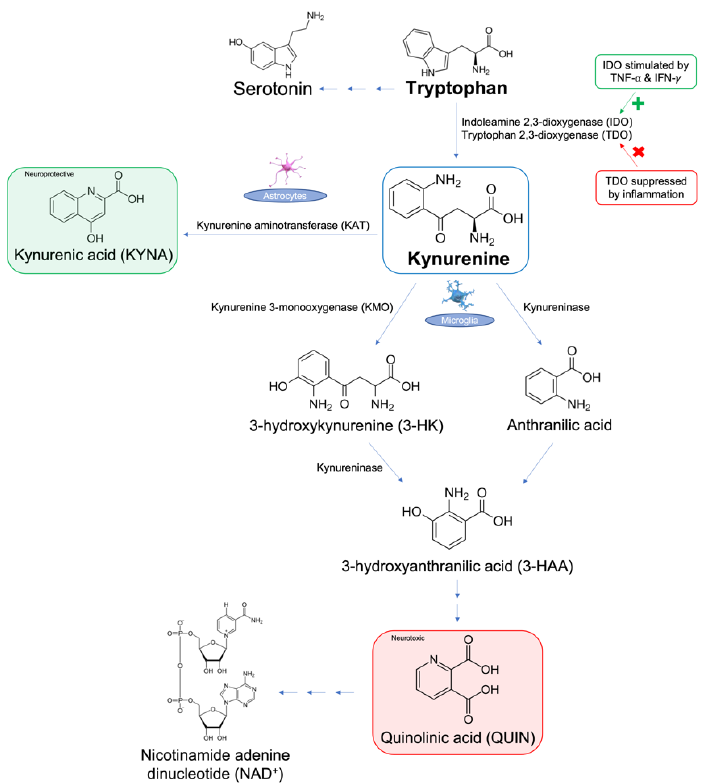
Figure 1. Overview of the metabolism of tryptophan via the kynurenine